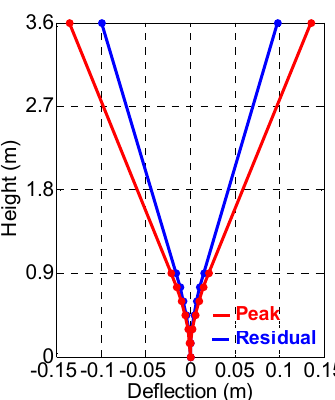
Figure 9. Residual versus peak deflections of the S-C column along the height.